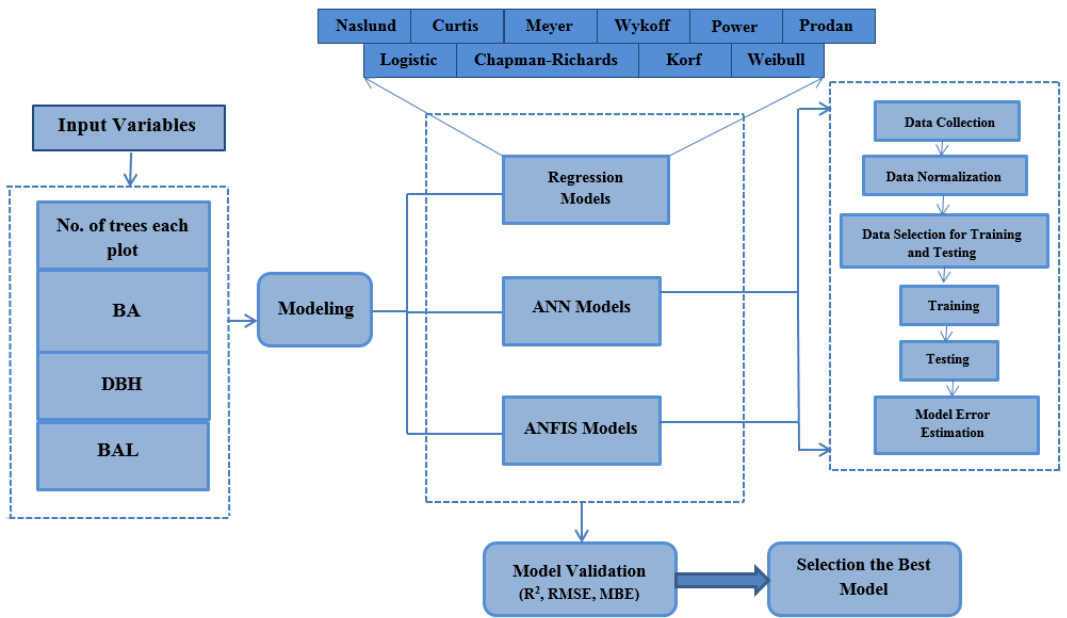
Figure 2. The workflow employed in this study to quantify the tree heights using artificial intelligence and empirical models. BA: basal Area (m 2 ha − 1 ), DBH: diameter at breast height (cm), BAL: basal area in the largest tree (m 2 ha − 1 ).